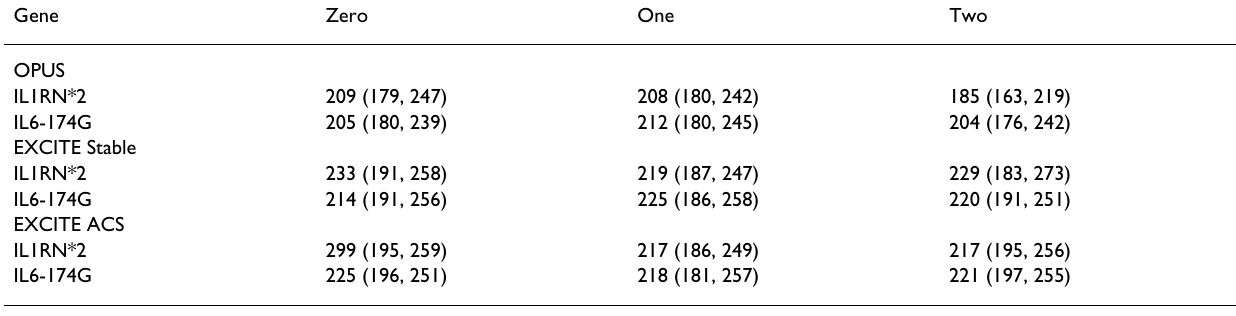
Table 5: OPUS TIMI-16 study: Platelet count median (Q1, Q3). Gene